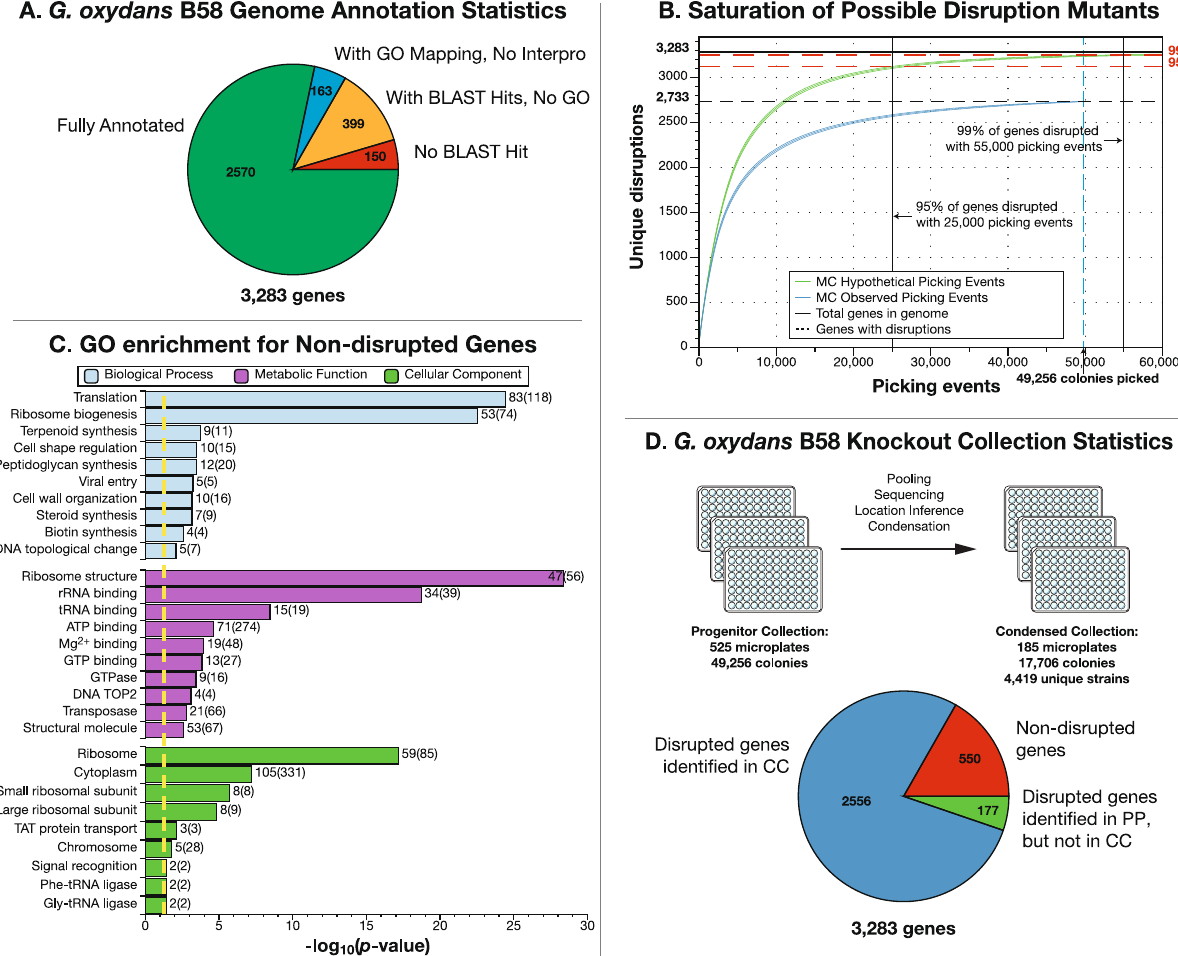
Fig. 1 Knockout Sudoku was used to curate a saturating coverage transposon insertion mutant collection for Gluconobacter oxydans B58. A The G. oxydans B58 genome contains 3283 genes. Two thousand fi ve hundred and seventy genes were fully annotated with a BLAST hit, InterPro ID, and gene ontology (GO) group. An additional 163 genes had an annotation and GO group but lacked an InterPro ID; 399 retrieved only a BLAST hit, and 150 were unable to be assigned any annotation. B A Monte Carlo (MC) estimate (green curve) of the number of genes represented by at least one mutant as a function of the number of mutants collected demonstrated that picking 25,000 mutants would yield at least one disruption for 95% of genes, while picking 50,000 mutants would yield at least one disruption for 99% of genes. In total, we picked 49,256 single-gene disruption mutants and located at least one disruption for 2733 genes. A Monte Carlo simulation (blue curve) of picking with random drawing from the sequenced progenitor collection (PC) without replacements demonstrates that the genome coverage was truly saturated. The center of each curve is the mean value of the unique gene disruption count from 1000 simulations, while the upper and lower parts of each curve represent two standard deviations around this mean. C A one-sided Fisher ’ s exact test for gene ontology enrichment among the non-disrupted (putatively essential) genes revealed signi fi cant enrichment ( p < 0.05, yellow line) of genes involved in translation and other ribosome-related functions. D The curated condensed collection (CC) contains 17,706 isolated colonies across 185 plates. High-throughput sequencing of the CC con fi rmed the location for 4419 unique disruption strains, representing disruptions in 2556 genes. Hundred and seventy-seven genes located in the PC were not located in the CC. No disruption mutant was detected in 550 (see “ Methods ” section) that have a transposon insertion in an production (Supplementary Fig. 2). The new collection was re- assayed with TB and BPB assays, and the strength and signi fi cance of each result were determined by comparison with pWT through a Bonferroni-corrected t -test (see “ Methods ” section). Mutants that cause the 25 largest reductions and 50 largest increases in endpoint acidity yet do not affect the growth rate are shown in Fig. 2D. A full set of mutants that cause signi fi cant changes in acidi fi cation are listed in Supplementary Data 6.